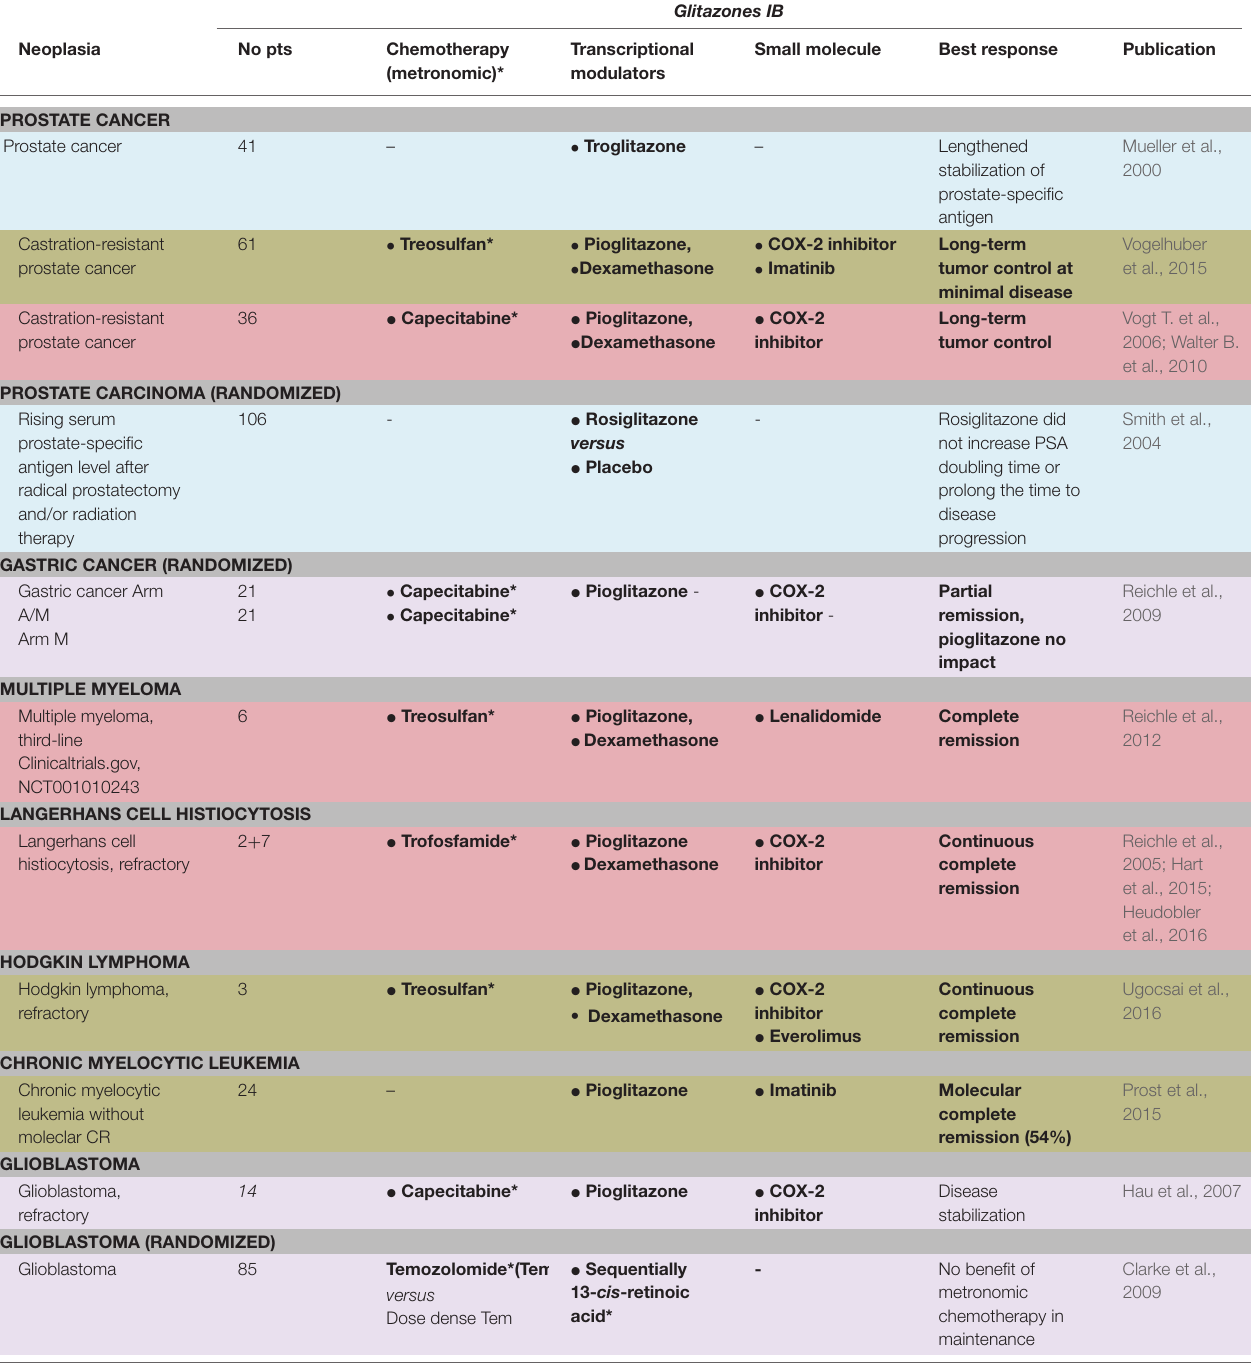
TABLE IB | Communicative reprogramming of tumor